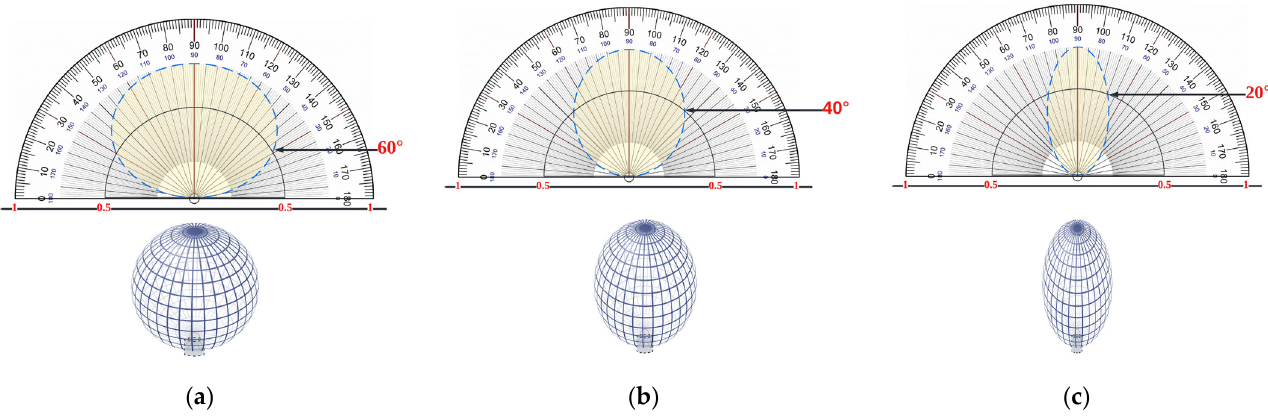
Figure 3. 2-D and 3-D views of LED source radiation patterns, ( a ) φ1/2 = 60°, ( b ) φ1/2 = 40°, and ( c ) φ1/2 = 20°. ( c ) ϕ 1/2 = 20 ◦